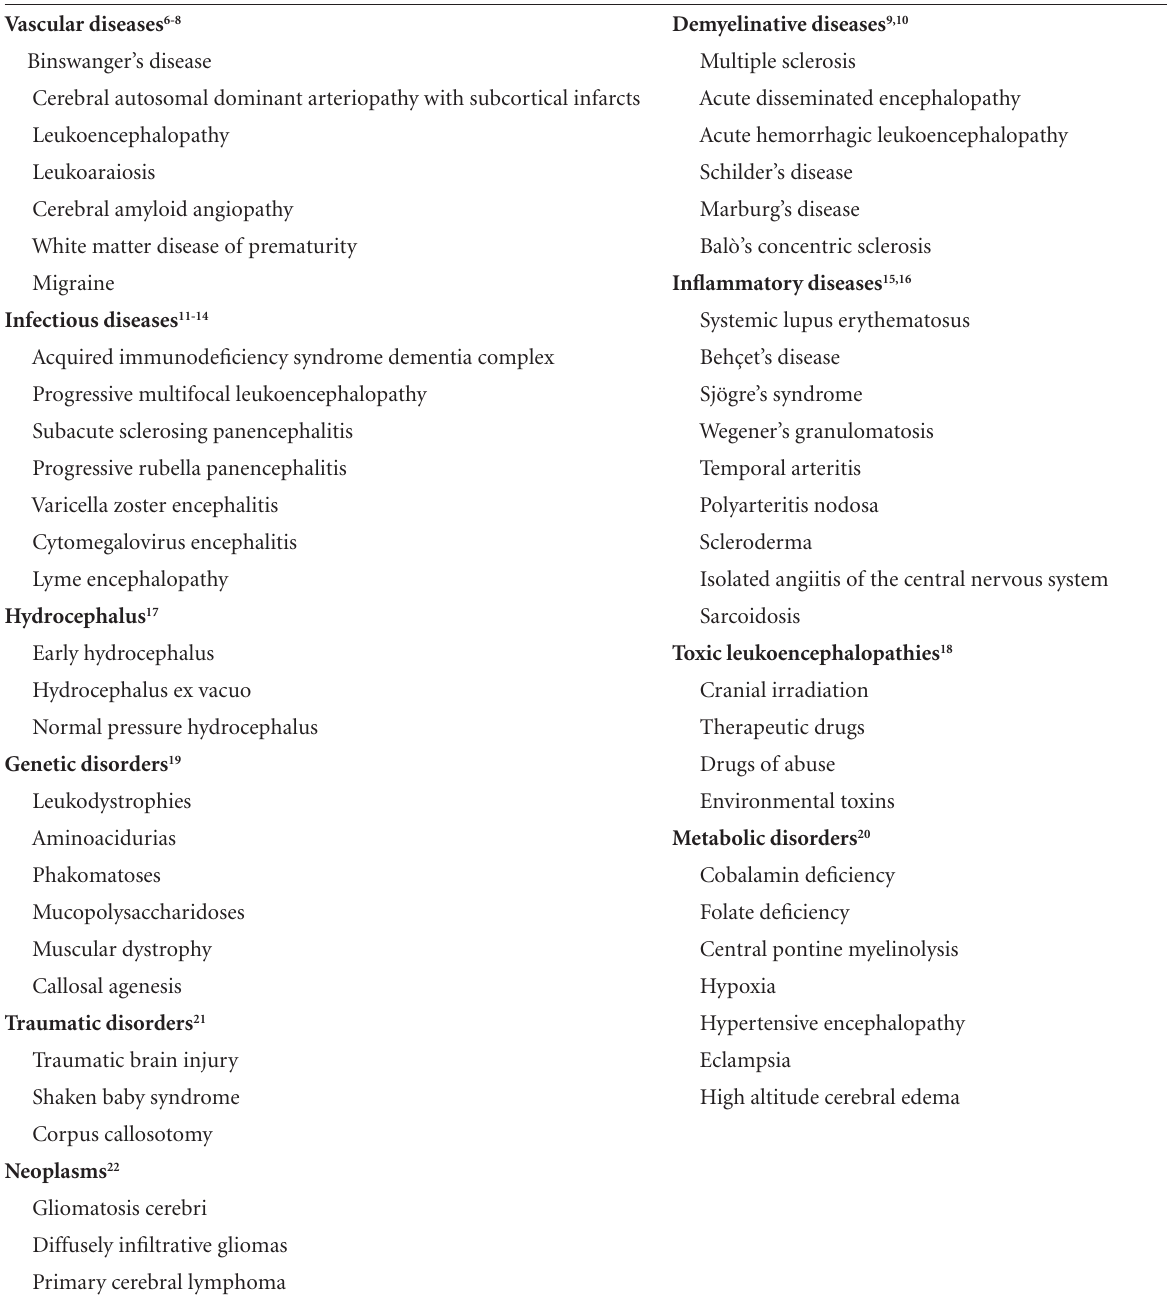
Table 1. Causes of cognitive impairment and dementia related to white matter